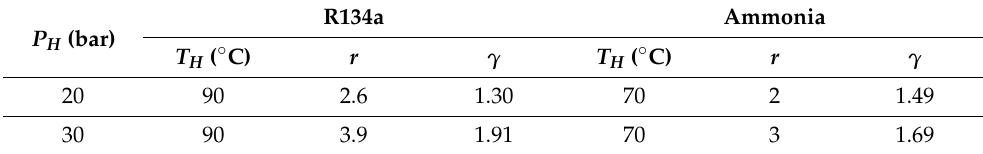
Table 2. Heat capacity ratios.